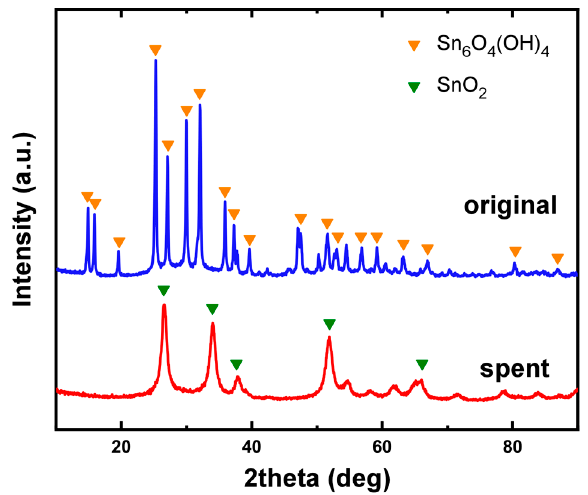
Figure 2. XRD diagrams of spent and corresponding original adsorbent.